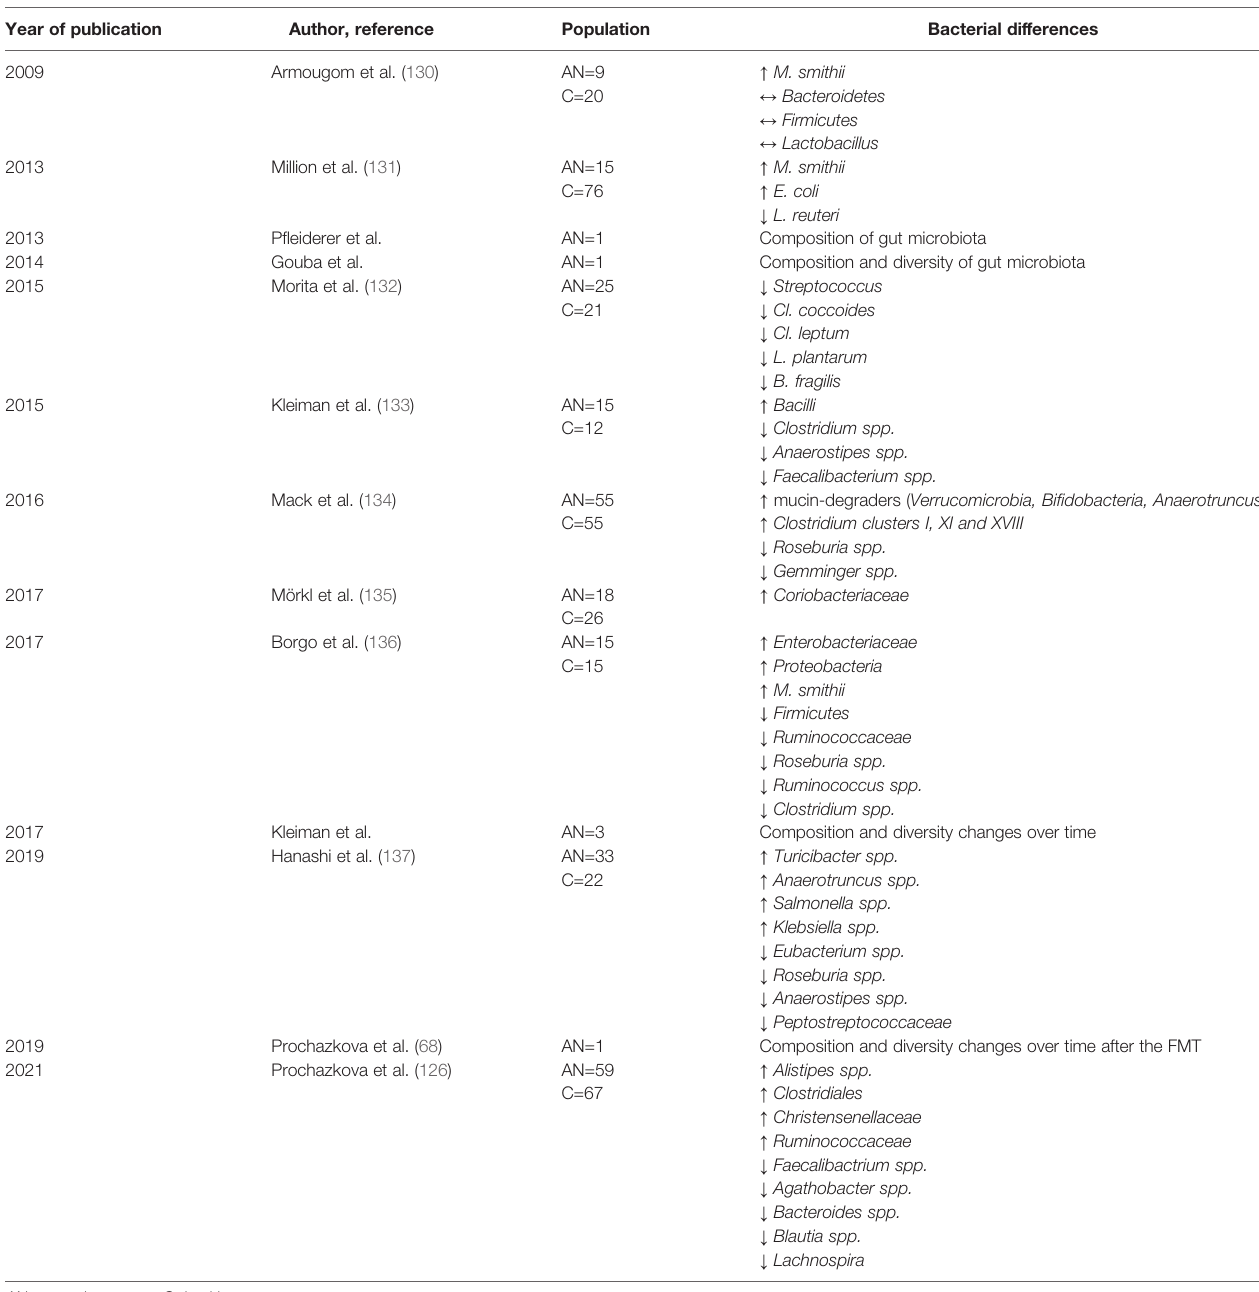
TABLE 2 | Gut microbial studies in patients with